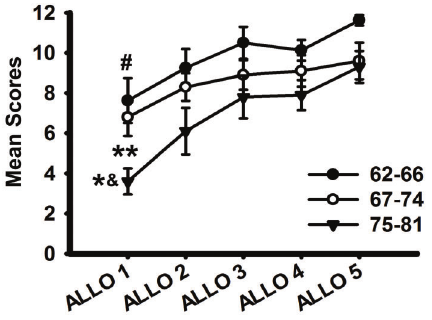
Figure 2. Mean scores of the groups in the allocentric trials (1 to 5). Signi fi cant differences were found in the fi rst trial between the 62 – 66 and 75 – 81 groups of age (*P=0.014), as well as between the 67 – 74 and 75 – 81 groups of age ( & P=0.03). Improvement across trials was also found in the 62 – 66 group, with a lower score in the fi rst trial compared to the fi fth trial ( # P=0.003). The 75 – 81 group also showed an improvement across learning trials, with a lower score in the fi rst trial than in the rest (second to fi fth) (**P o 0.001). Data are reported as means ± SD